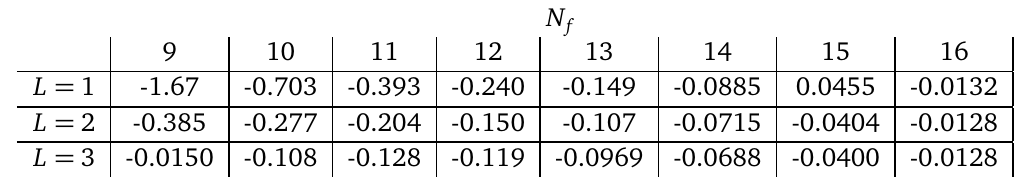
Table 4: Anomalous dimension γ ∗ serting the L + 1 loop critical coupling α ∗ .